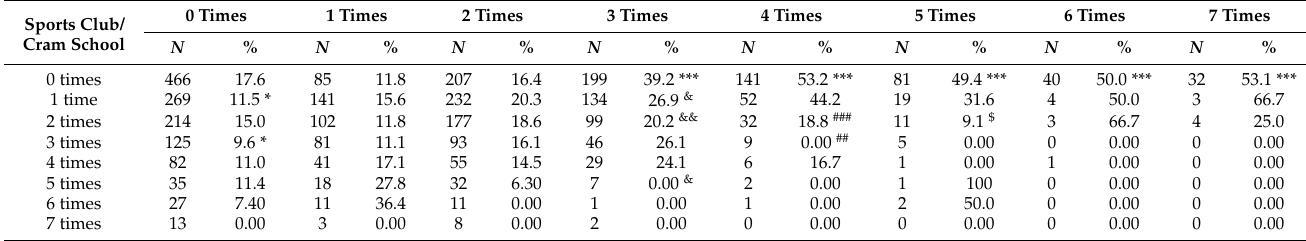
Table 4. Relationship between sports club and/or cram school attendance and the rate of wearing glasses. Sports Club/ Cram School